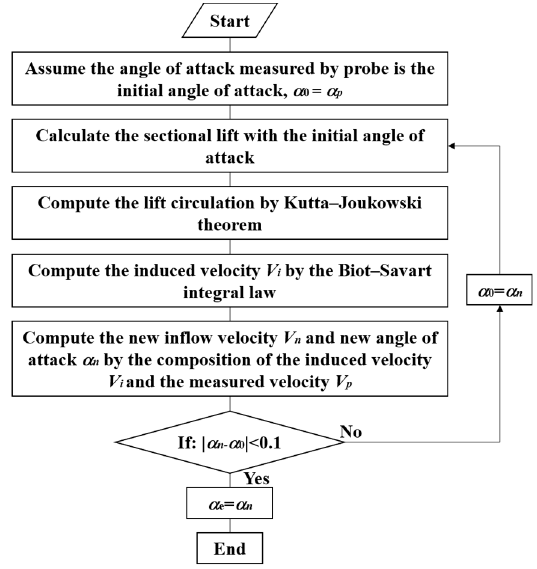
Figure 10. The flowchart to calculate the effective angle of attack.